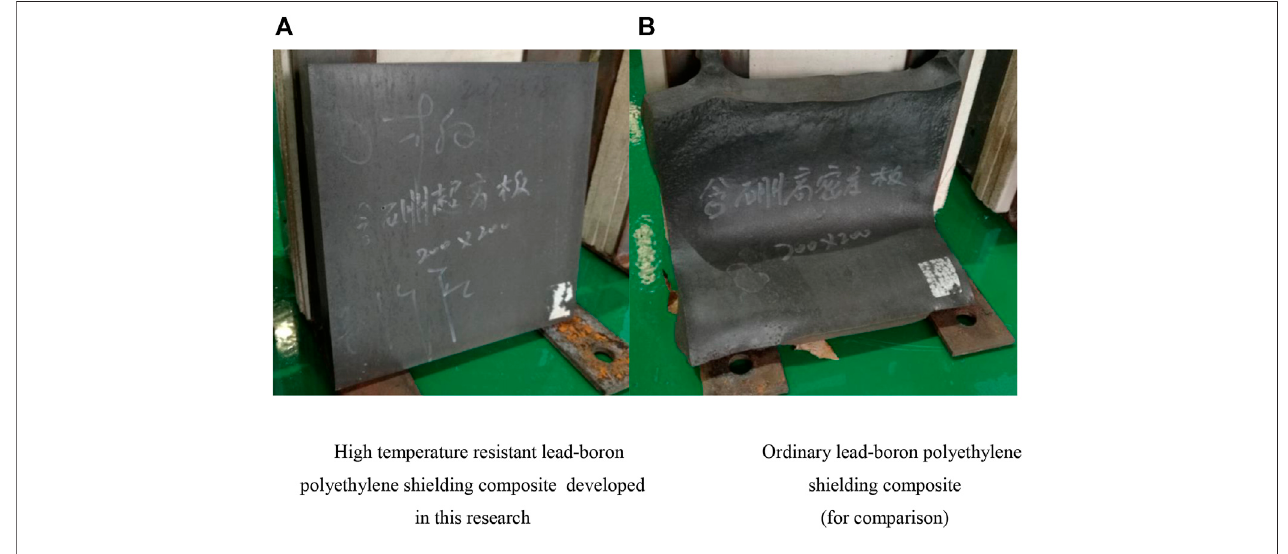
FIGURE 4 | Samples after the LOCA